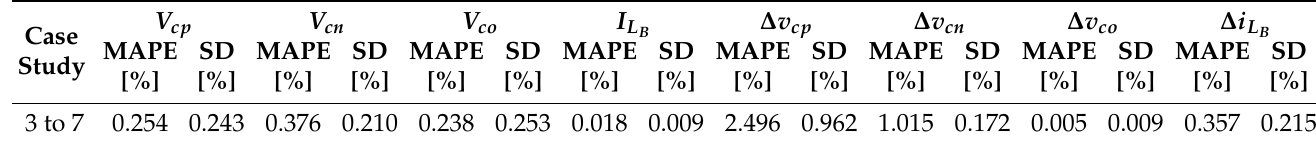
Table 6. Percentage error statistical results of the proposed converter with Duty cycle